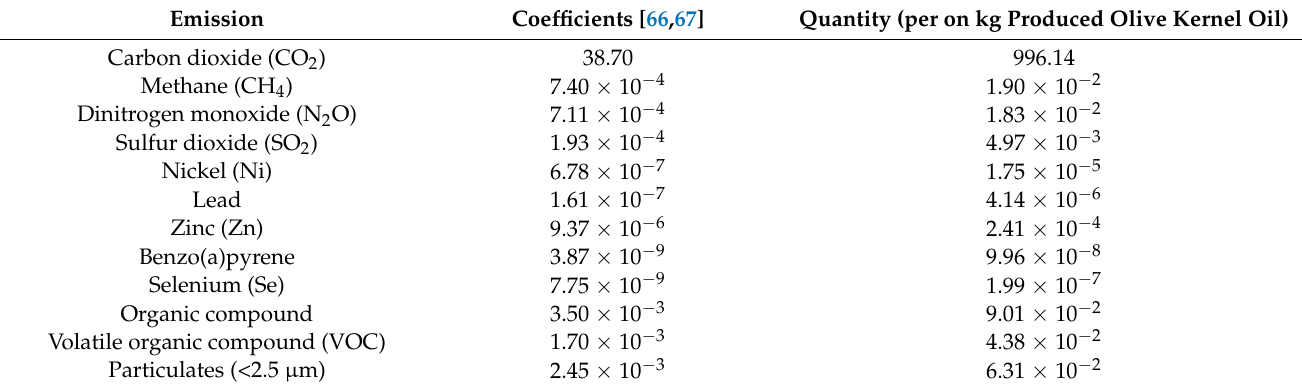
Table 2. Coefficients for calculation of emissions from natural gas combustion